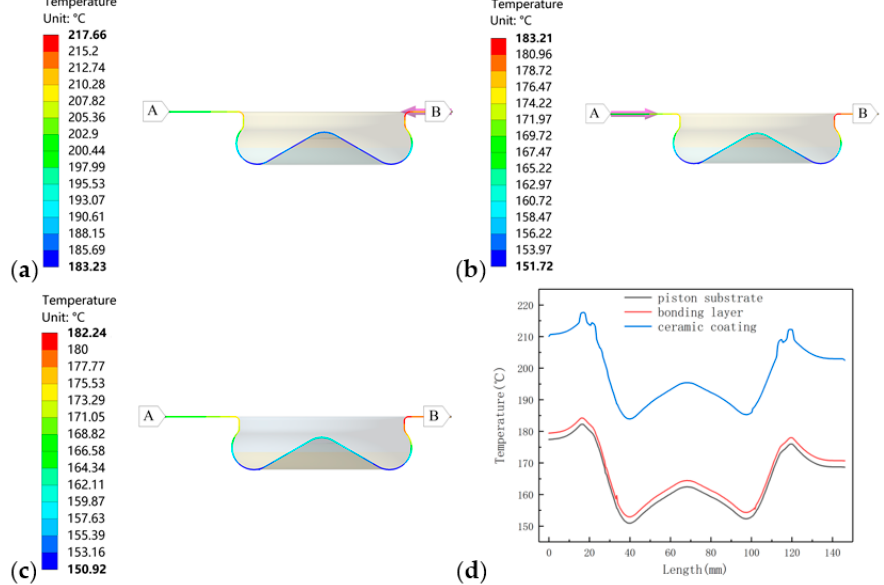
Figure 12. Path AB of TBC piston: ( a ) the top ceramic coating; ( b ) the bonding layer; ( c ) the top of the piston substrate; ( d ) the temperature distribution of the heat ceramic coating, the bonding layer and the piston substrate, respectively, along the path AB.